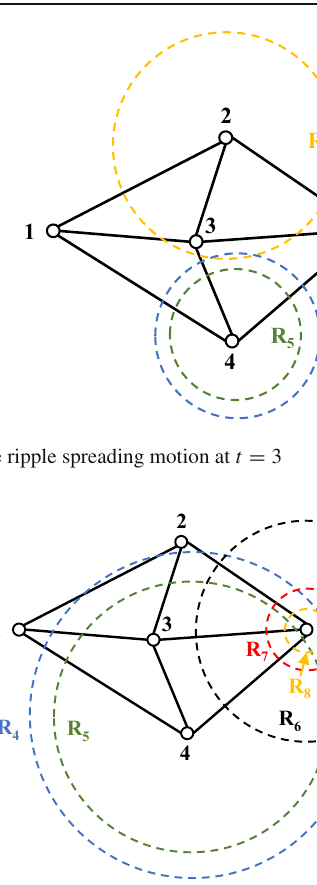
Fig. 10 The ripple spreading motion at t = 4